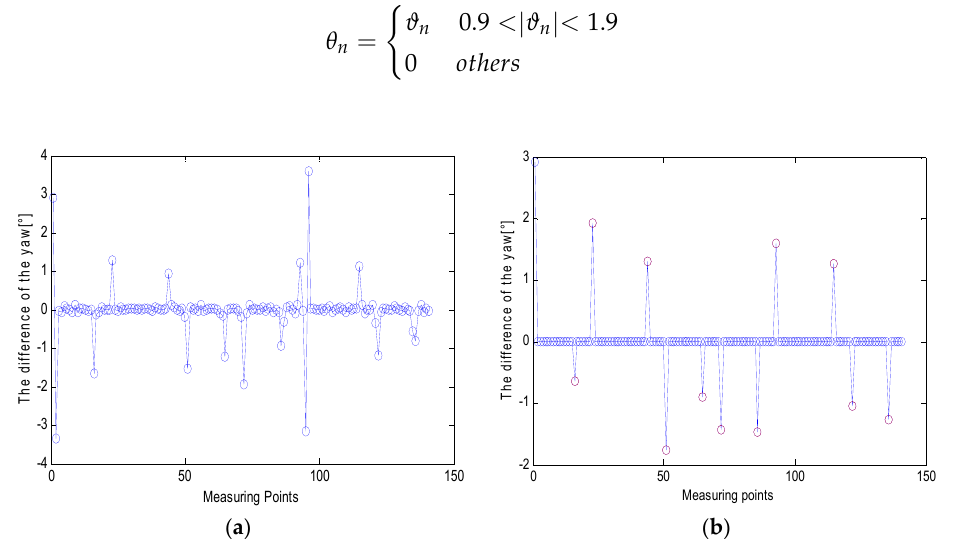
Figure 13. ( a ) The difference of the heading angle before corrected and ( b ) the difference of the heading angle after correction.